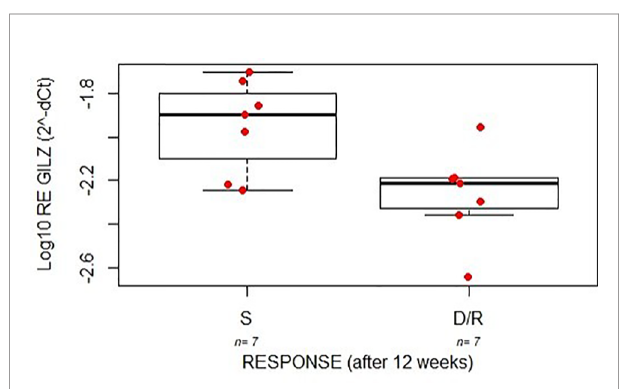
FIGURE 4 | The boxplots indicate the expression level (relative log expression) of GILZ between good (S) and poor (D/R) responders after 12 weeks of treatment with GC in a cohort of young patients with